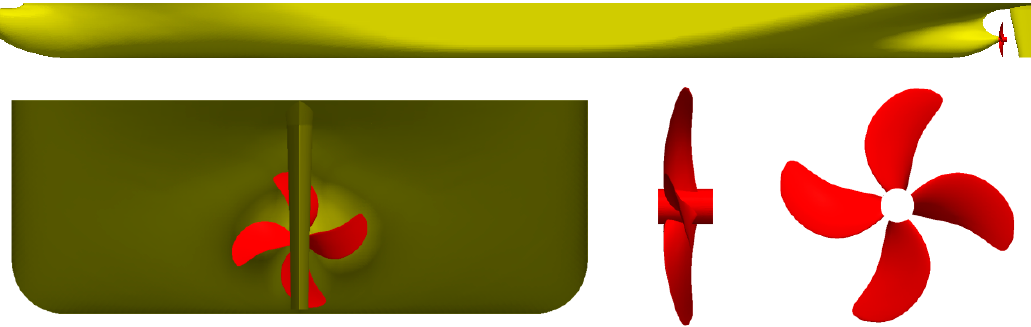
Figure 1. YUPENG ship and propeller geometry model.